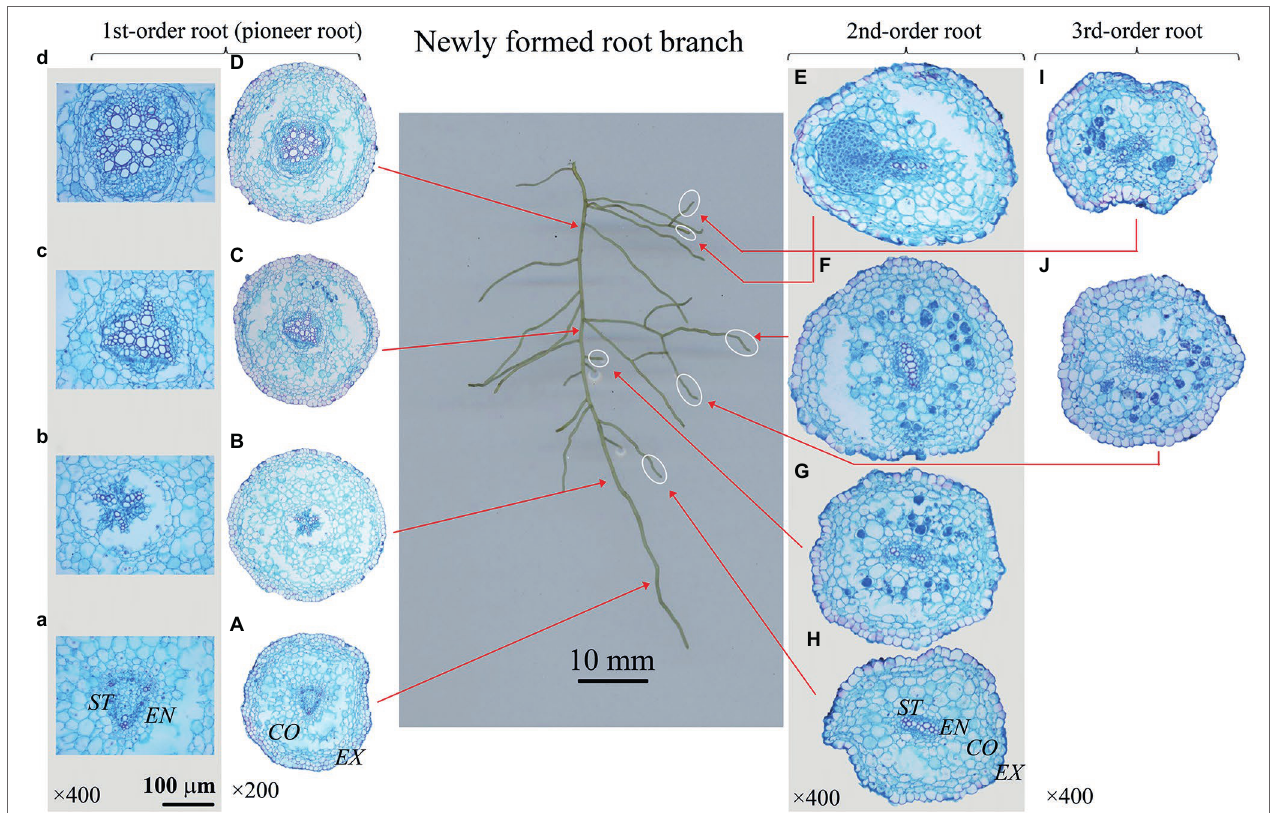
FIGURE 4 | Protoxylem group (PG) arrangement along root developmental order of Phellodendron amurense under control. There were three PGs (A-C) in first- order root, and two PGs (E-J) in second- and third-order roots. The nature of PG in first-order root was obvious in primary (A-C) , but lost in secondary growth (D) . EX , exodermis; CO , cortex; EN, endodermis; ST ,